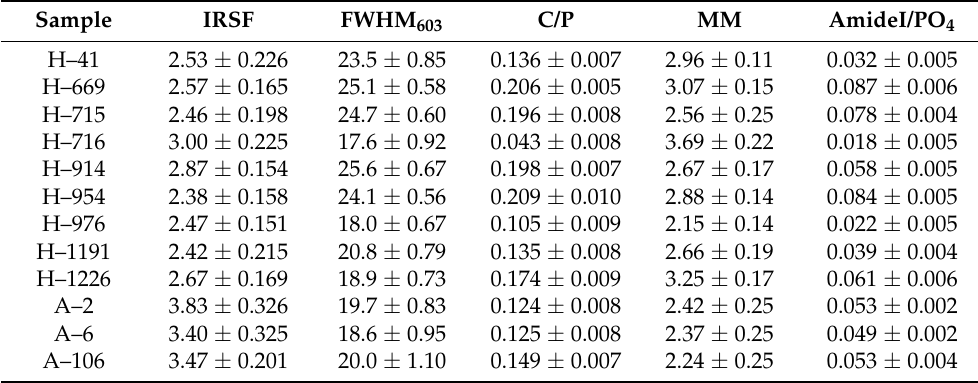
Table 2. Diagenetic parameters calculated by ATR–FTIR analysis of human and animal bone samples collected at the Fewet oasis: IRSF, FWHM 603 , C/P, MM, and amide I/PO 4 . Data are reported as mean ± S.D.